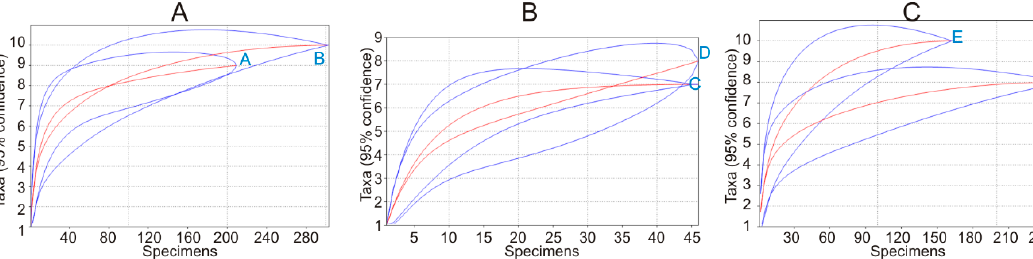
Figure A5 . Species accumulation curves for control habitats and commercial fruit farms in the 2018 study of small mammals in Lithuania: ( A ) control habitats (A) and commercial fruit farms (B) with summer and autumn season data pooled (diversity H = 1.66 ± 0.002 and H = 1.73 ± 0.003, respectively, t = 1.08, differences not significant); ( B ) control habitats (C) and commercial fruit farms (D) in summer (H = 1.81 ± 0.007 and H = 1.66 ± 0.0, t = 1.14, NS); ( C ) control habitats (E) and commercial fruit farms (F) in autumn (H = 1.64 ± 0.006 and H = 1.53 ± 0.02, t = 1.06, NS).